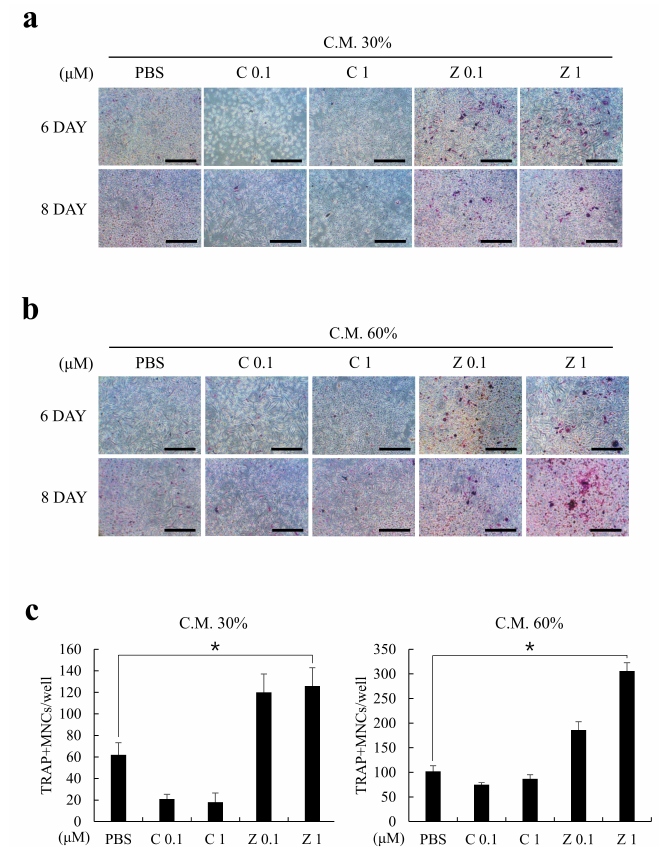
Figure 3. Zoledronate, but not clodronate, induced the secretion of pro-osteoclastogenic factors from MLO-Y4 cells. MLO-Y4 cells were cultured with or without clodronate (C; 0.1 or 1 µ M) or zoledronate (Z; 0.1 or 1 µ M) and the C.M. was collected as in Figure 2a (upper). ( a ) Osteoclast differentiation was induced on bone marrow-derived macrophages (BMMs) by the medium containing C.M. 30% + F.M. 70% for the indicated days (without extrinsic addition of M-CSF & RANKL). Osteoclasts were visualized by tartrate-resistant acid phosphatase (TRAP) staining and the representative images are shown. Bars, 200 µ m; ( b ) BMMs were cultured as in ( a ) with C.M. 60% + F.M. 40% mixed medium; ( c ) TRAP+ multinucleated cells (MNCs) were quantified from ( a , b ) experiments. All quantitative data are presented as mean ± SD (* p <